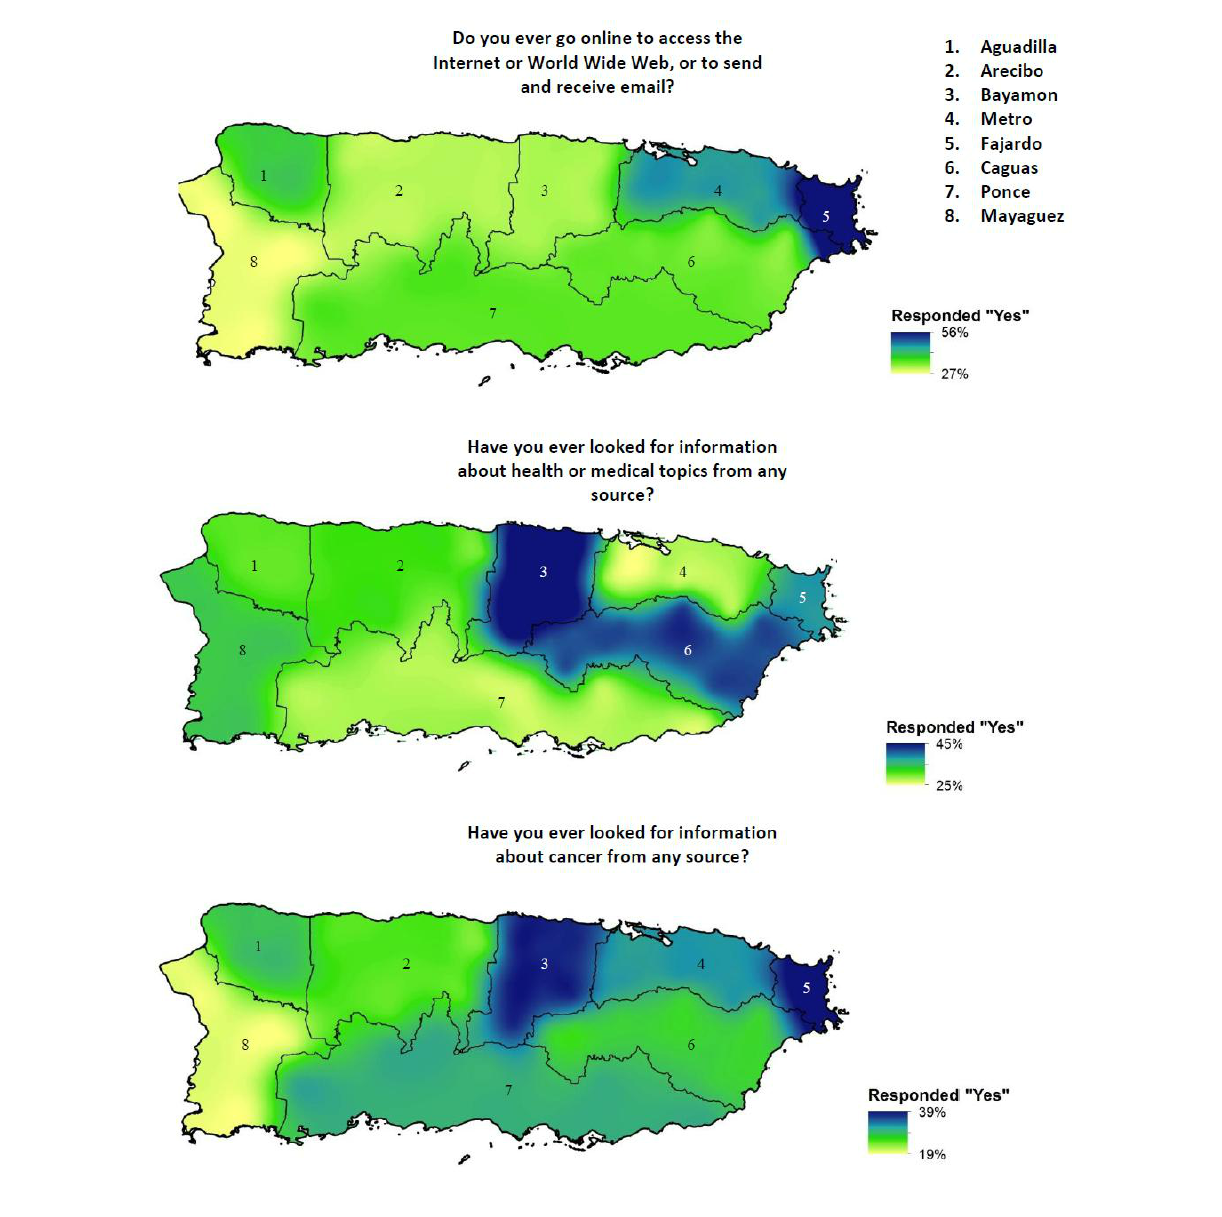
Figure 1. Geographic distribution of Internet use and health and cancer information